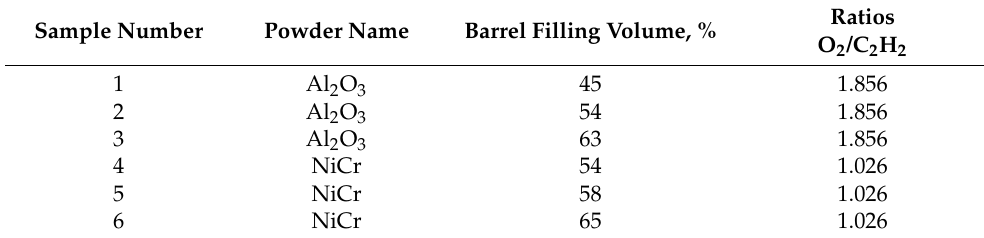
Table 2. Technological parameters for obtaining NiCr-Al 2 O 3 coatings.